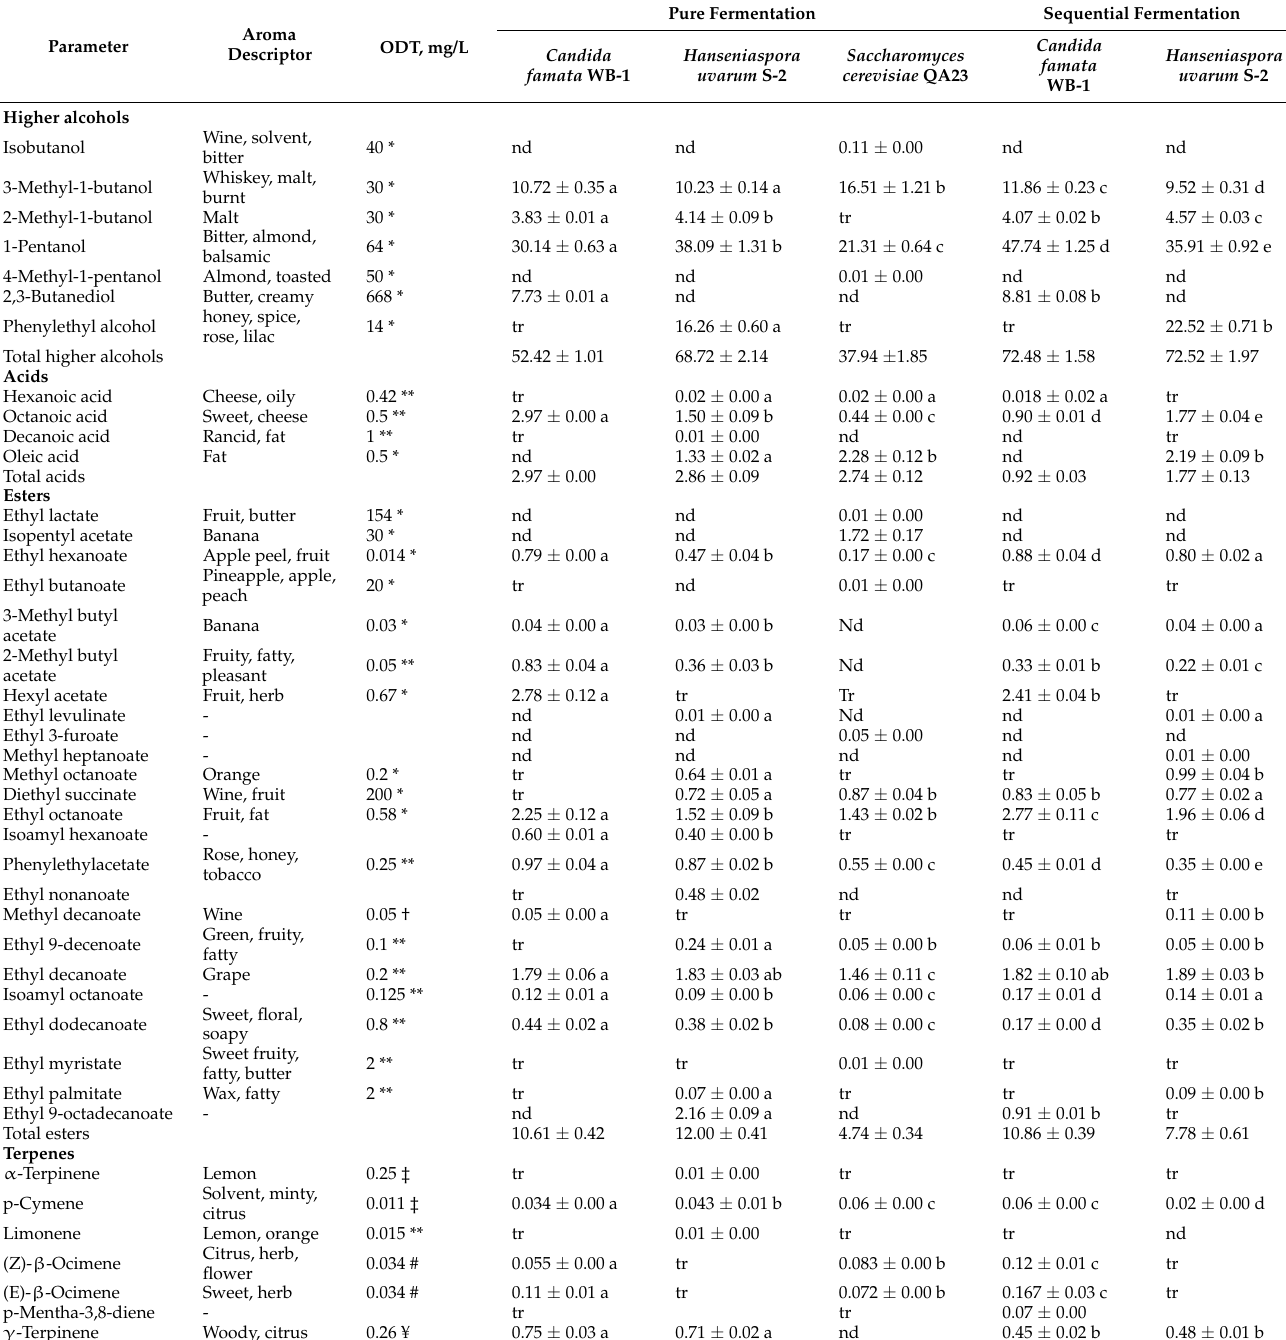
Table 2. Concentration of volatile components (in mg/L) found in the Tamjanika wine samples produced in pure and sequential fermentations inoculated with C. famata WB-1, H. uvarum S-2, and S. cerevisiae QA23